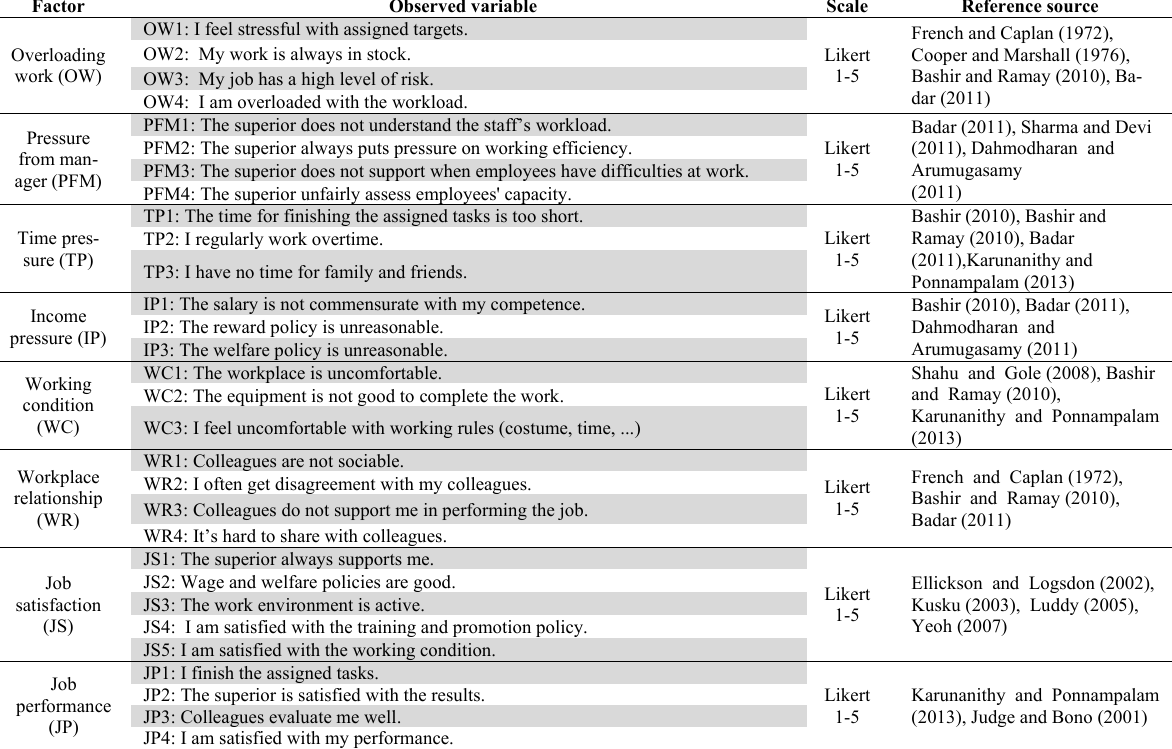
Interpretation of observed variables in the research model Factor Observed variable Scale Reference